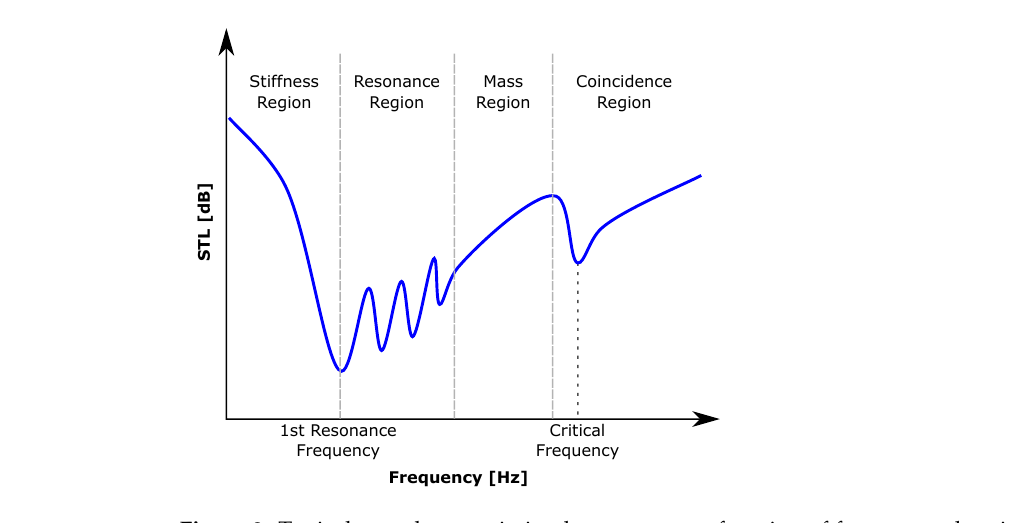
Figure 2. Typical sound transmission loss curve as a function of frequency, showing the stiffness, resonance, mass and coincidence